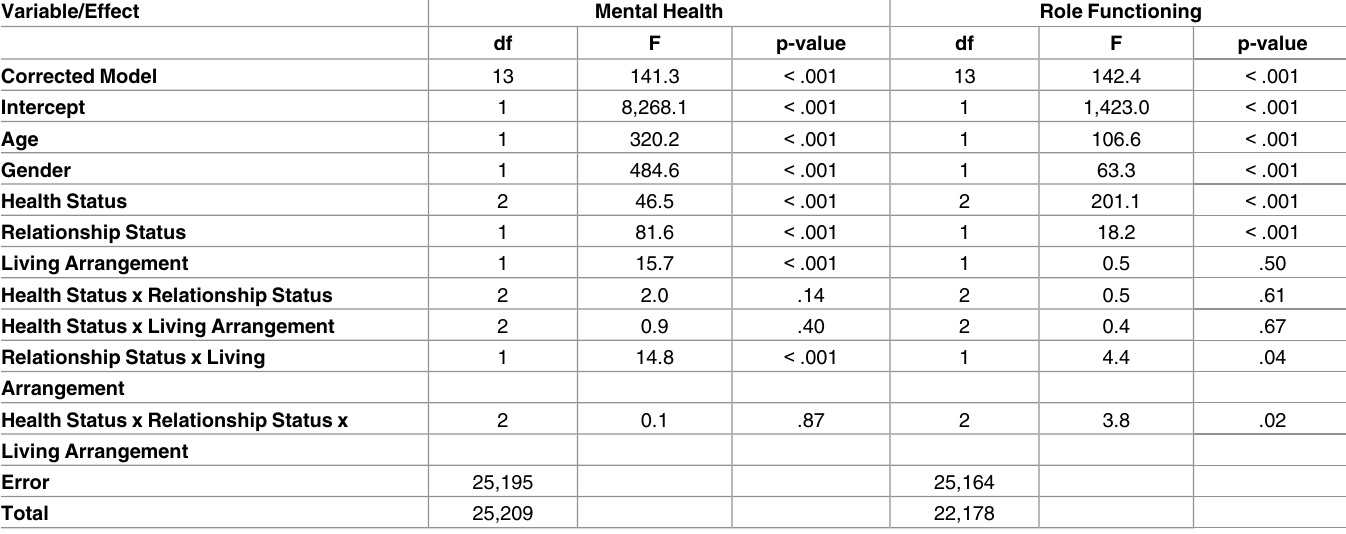
Table 4. Results of the ANCOVAsfor mental health and role